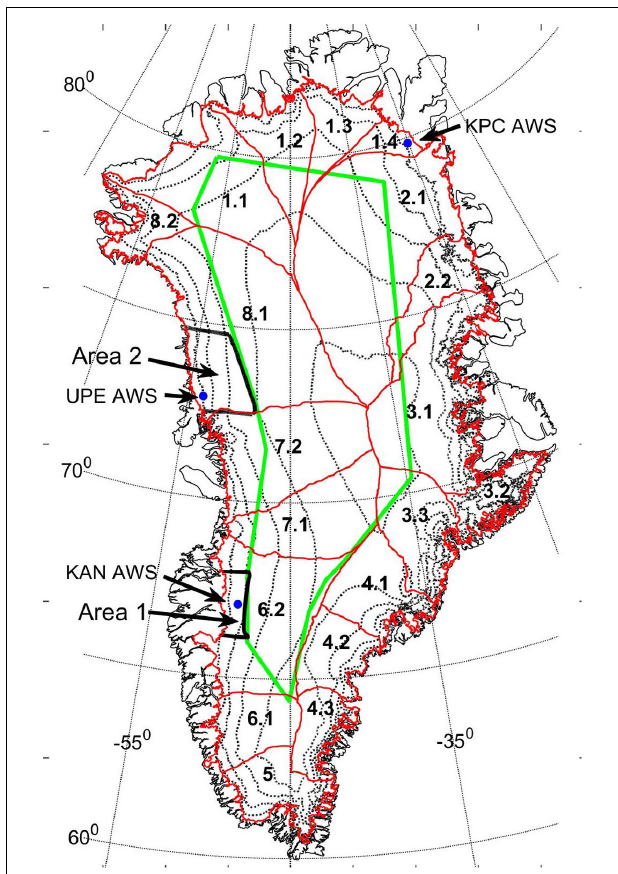
FIGURE 1 | Illustration of the positions of the three Program for Monitoring the Greenland Ice Sheet (PROMICE) automatic weather stations (AWS) referred to in this study and the red-outlined Zwally basins. The outer red line reflects the outer edge of the ice sheet. The green line delineates the inner extent of coverage of the SARIn mode of the CryoSat radar altimeter and the outlines of the two areas referred to in the results section “Temporal Height Change in the Ablation and Lower Percolation Regions of Western Greenland” are outlined in